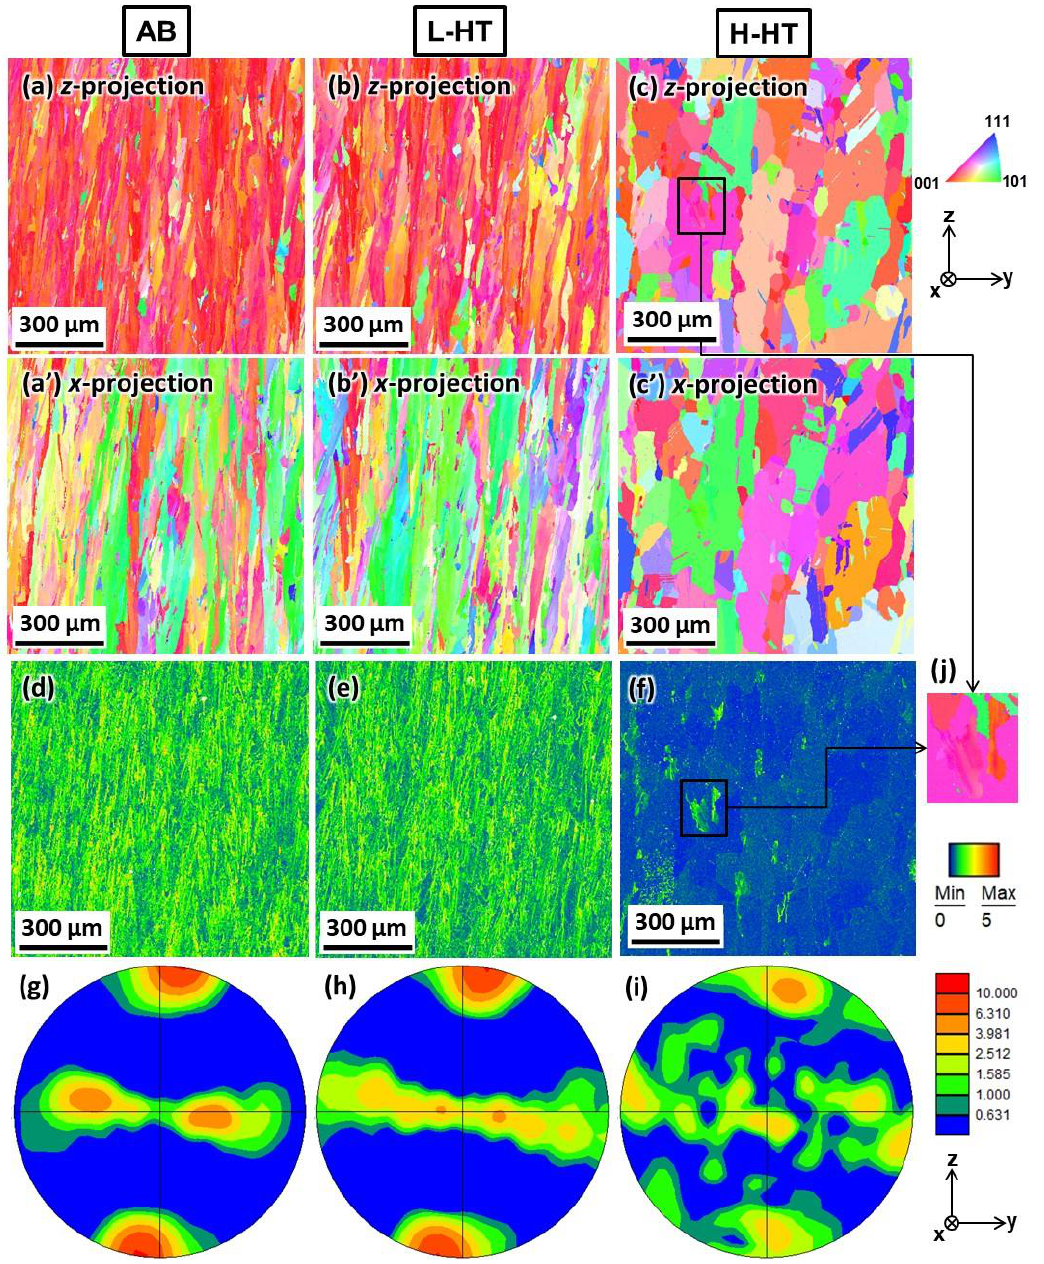
Figure 3. ( a – c , j ) IPF maps, ( d – f ) KAM maps, and ( g – i ) {001} pole figures for ( a , d , g ) AB, ( b , e , h ) L-HT-ed, and ( c , f , i , j ) H-HT-ed materials, obtained from the y – z plane. The IPF maps are projected ( a – c , j ) from the z -direction and ( a’ – c’ ) from the x -direction.